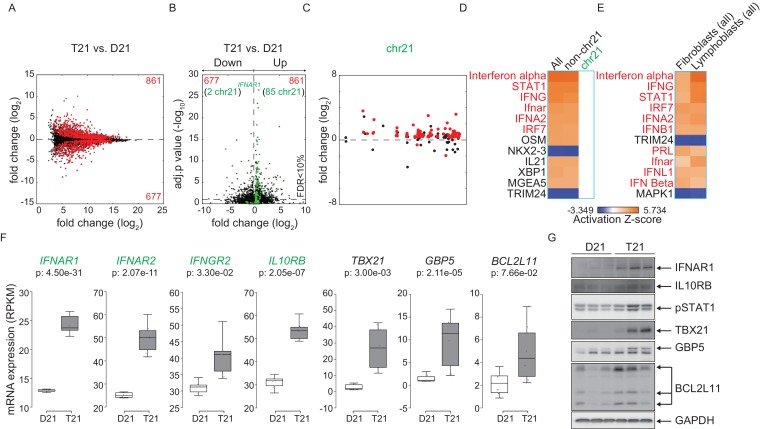
Activation of the interferon (IFN) transcriptional response is conserved in trisomy 21 (T21) lymphoblastoid cell lines.(A) MA plot displaying the gene expression signature associated with T21 in a panel of six lymphoblastoid cell lines, three of which harbor T21. Differential expressed genes (DEGs), as defined by DEseq2 (FDR < 10%), are labeled in red. (B) Volcano plot of DEGs with those encoded on chr21 highlighted in green. (C) Manhattan plot of chr21 with DEGs in red and all other genes in black. (D) Upstream regulator analysis reveals activation of the IFN transcriptional response in T21 lymphoblastoid cell lines. (E) Comparative analysis between fibroblasts and lymphoblastoids highlights conserved upstream regulators within the IFN pathway. (F) Box and whisker plots of RNA expression for the four IFN receptor subunits encoded on chr21 (green) and three interferon-related genes (black). mRNA expression values are displayed in reads per kilobase per million (RPKM). Benjamini-Hochberg adjusted p-values were calculated using DESeq2. (G) Western blot analysis confirming upregulation of IFN receptors, pSTAT1, and interferon related genes, at the protein level in T21 lymphoblastoids.